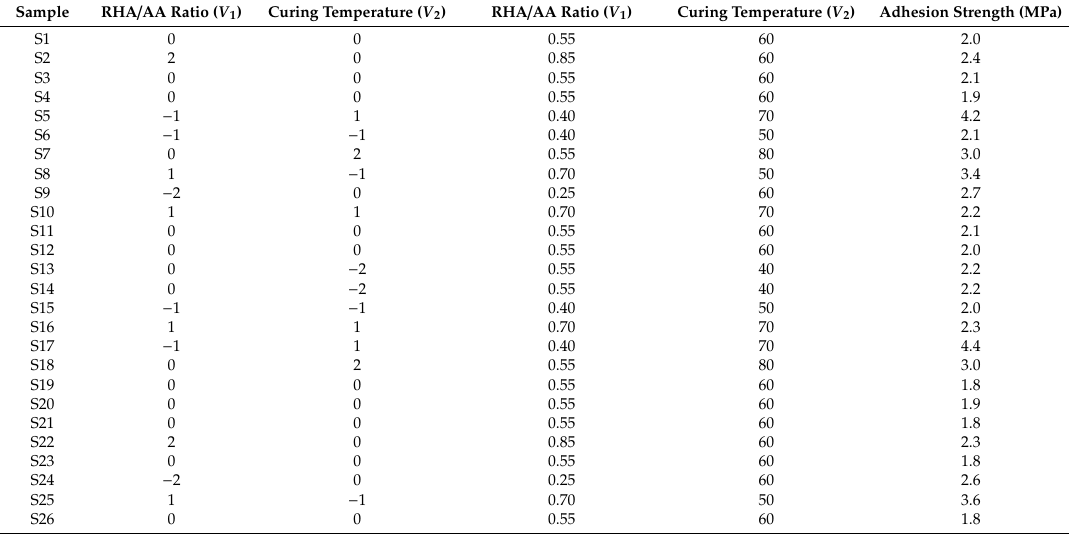
Table 5. Design matrix and response value for the adhesion test.